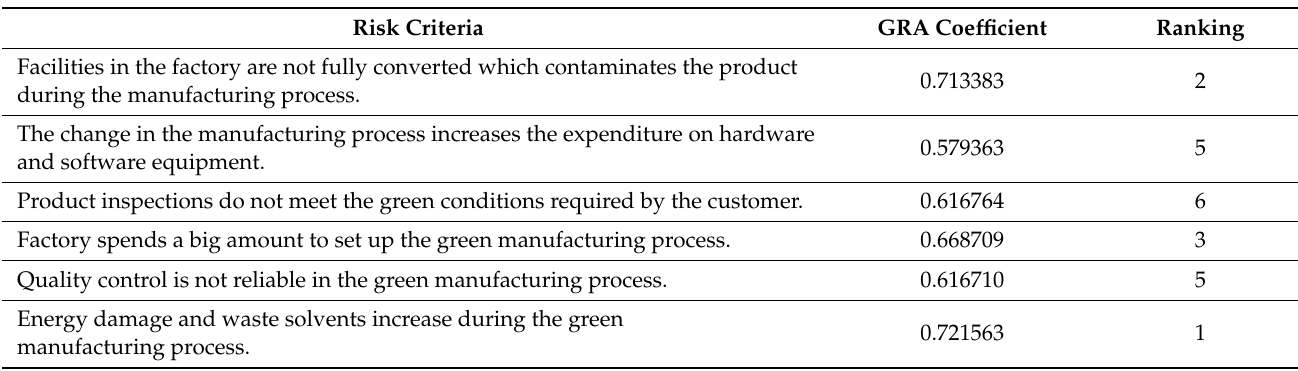
Table 7. The ranking of the green criteria in the green manufacturing process.